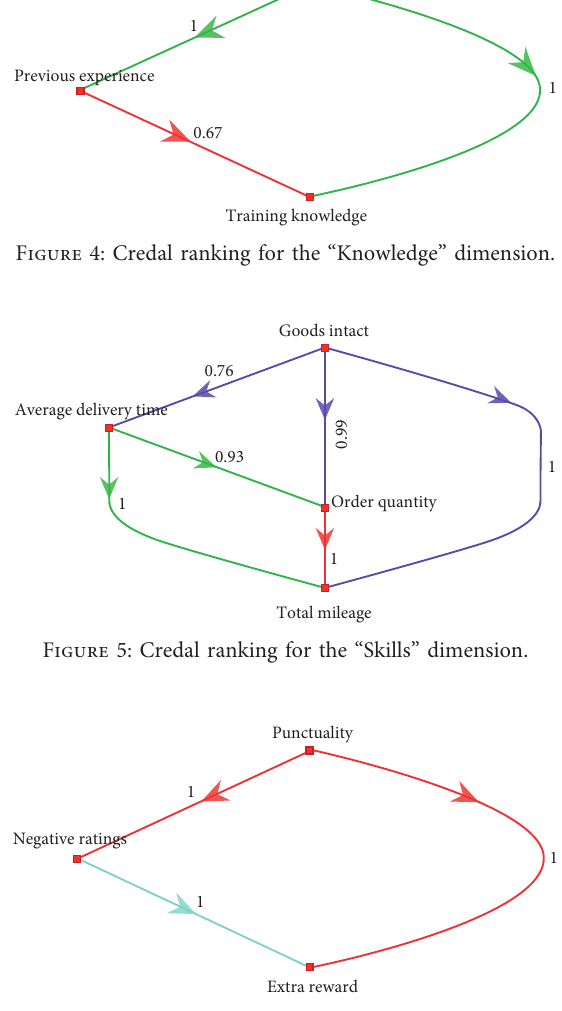
Figure 6: Credal ranking for the “Abilities” dimension.